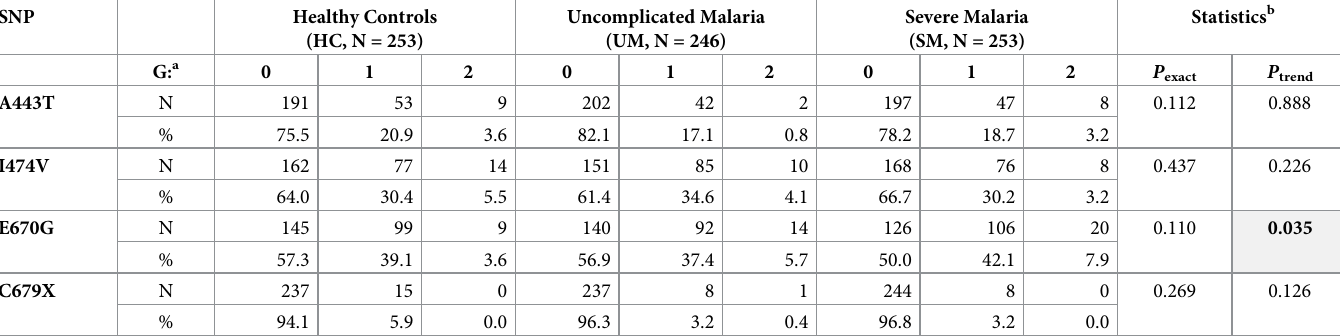
Table 2. Genotype distribution among healthy and malaria